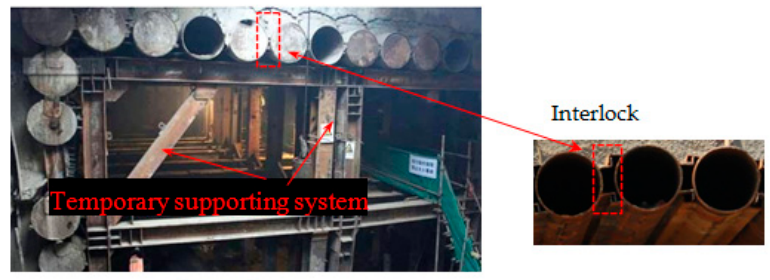
Figure 2. Traditional pipe-roofing system set-up.